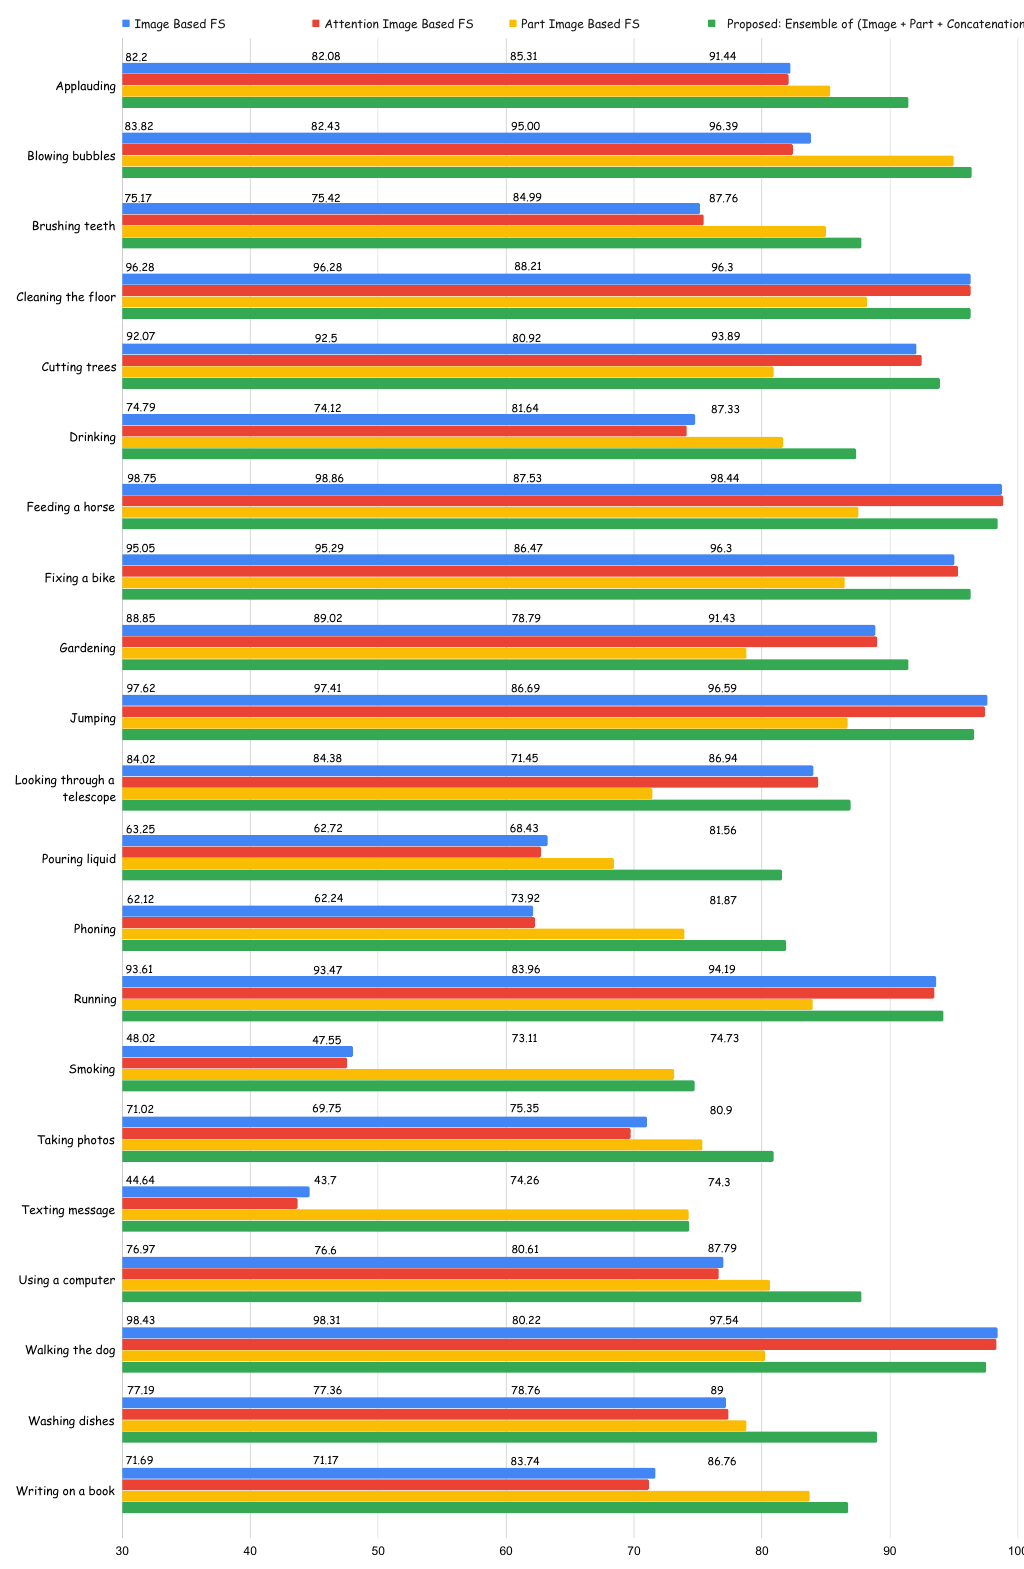
Figure 6. Detailed performance evaluation (average precision) of our proposed method. FS, feature stream. Results reported are on the Stanford 40 Actions Dataset [15]. Only some action classes are represented in the